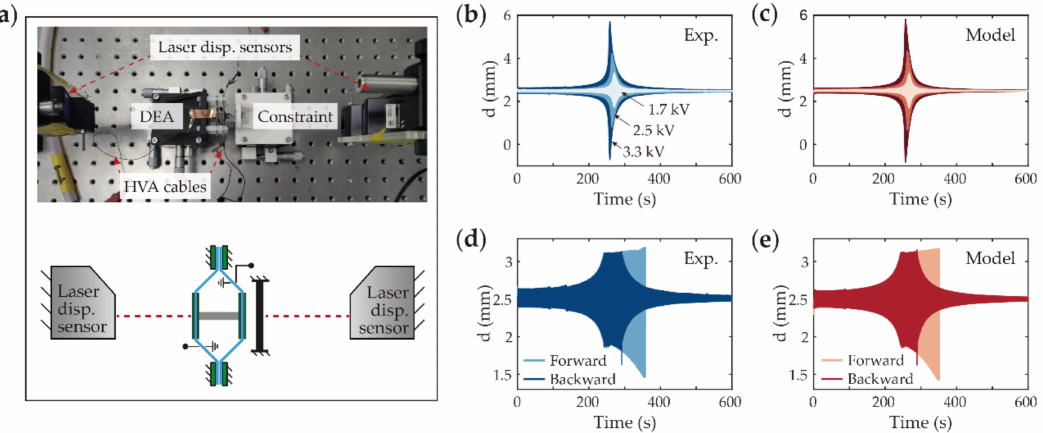
Figure 5. ( a ) Experimental setup of the frequency response characterization. ( b ) Measured forward frequency sweep results of the DEA with G >> resonant amplitude and at voltage amplitudes of 1.7, 2.5, and 3.3 kV. ( c ) Modelling results of the DEA at the same voltage cases. ( d ) Measured frequency sweep results of the resonant-impact DEA system with G = 0.6 mm. ( e ) Modelling results of the resonant-impact DEA